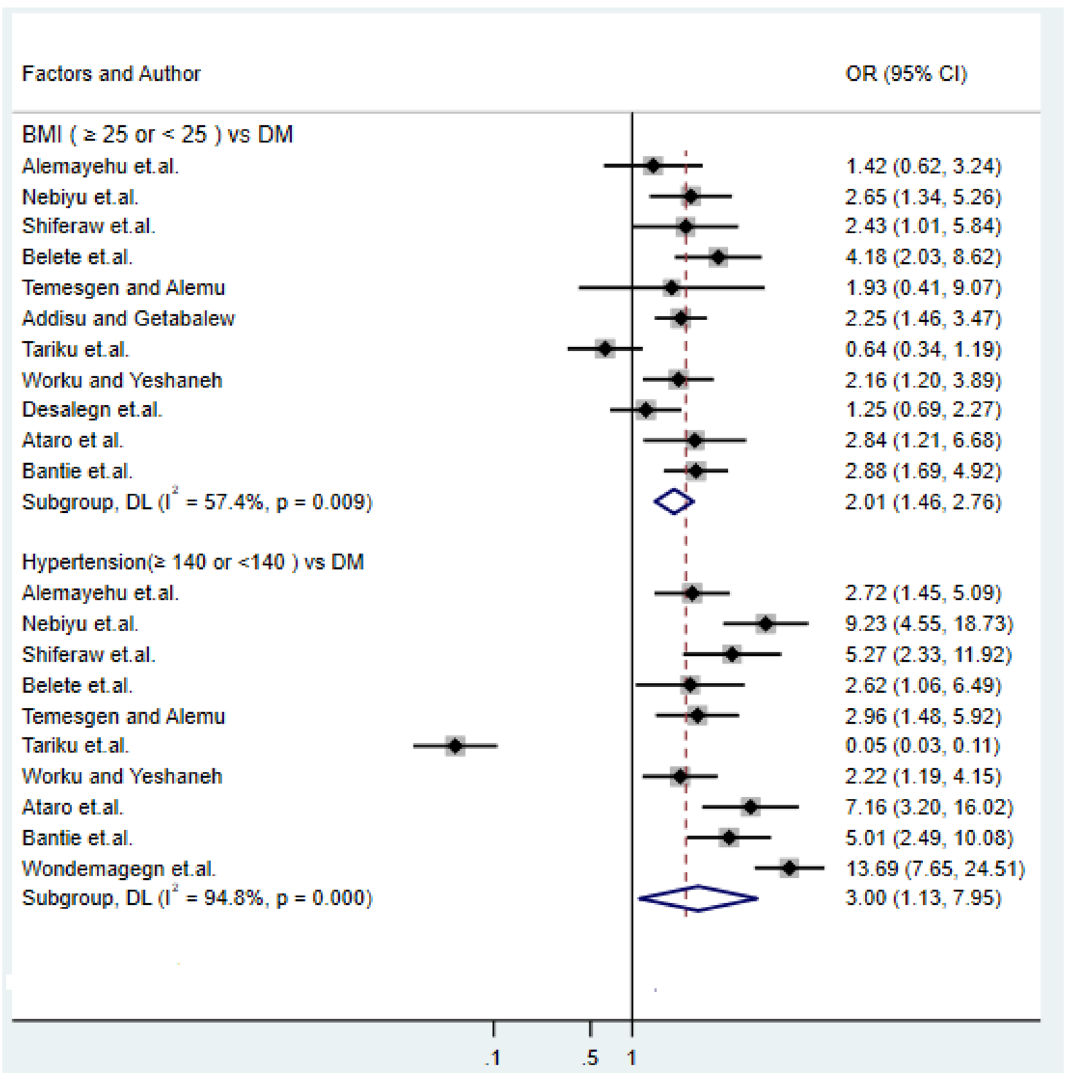
Figure 3. Forest plots of odds ratio for the association of body mass index and hypertension with type-2